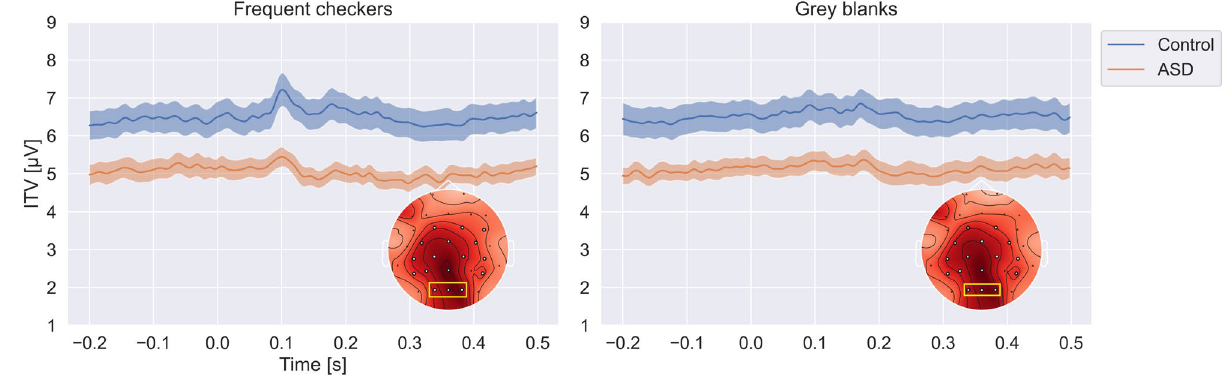
Figure 1. Inter-trial variability between groups. Blue traces show mean ITV of the control group, red shows the mean ITV of the ASD group averaged across the ROI electrodes (O1, Oz, O2; yellow rectangles in the topographic plots). Error shadings indicate group SEM. Left: Frequent checkers. Right: gray blanks. Topographic plots show the channel-wise ITV averaged over the time dimension and contrasted between the groups